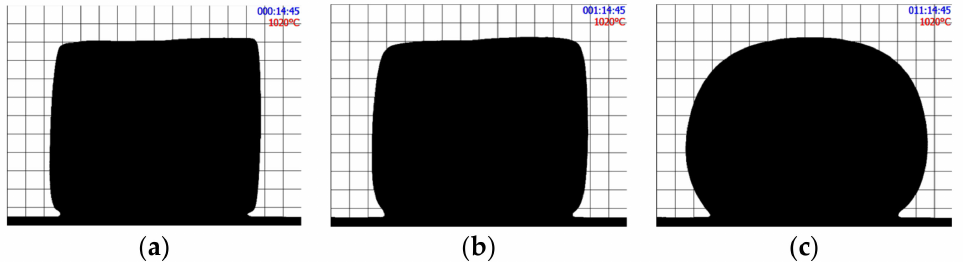
Figure 2. SmAS cubic glass sample heated at 1293 K. ( a ) At the beginning of the thermal plateau. ( b ) After 1 h at 1293 K. ( c ) After 11 h. The change in shape over 11 h is recorded and roundness on time is determined.